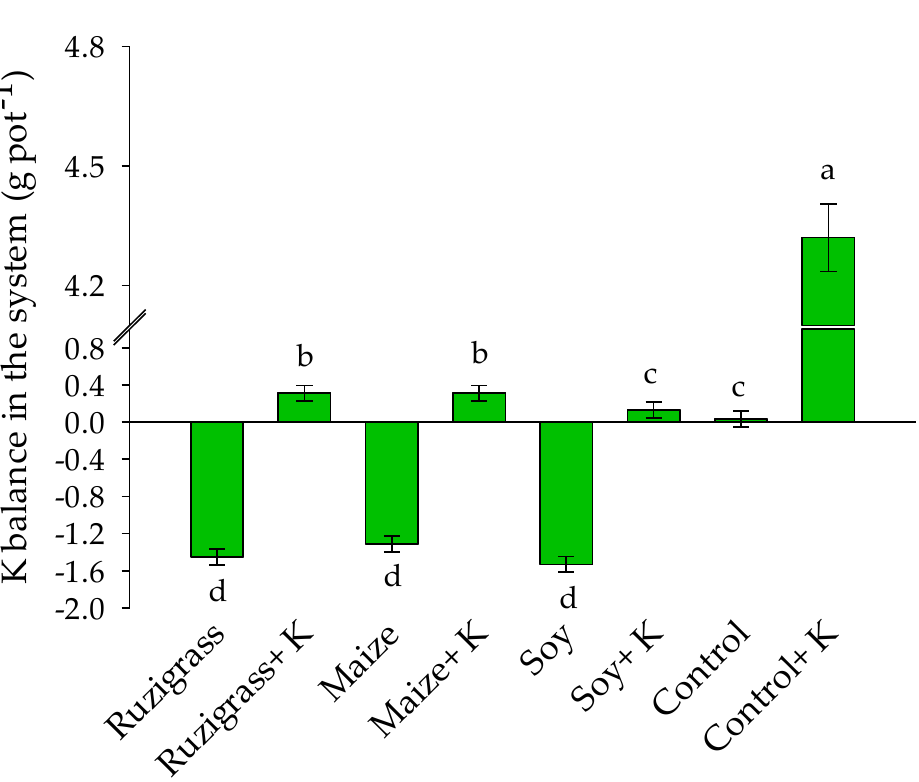
Figure 5. Potassium balance in the soil–plant system ((K bal = K fert − K abs − ∆ Ke) in relation to total K uptake after three crop growth cycles. Vertical bars represent standard error, and lowercase letters indicate difference between species (LSD, p ≤ 0.05).